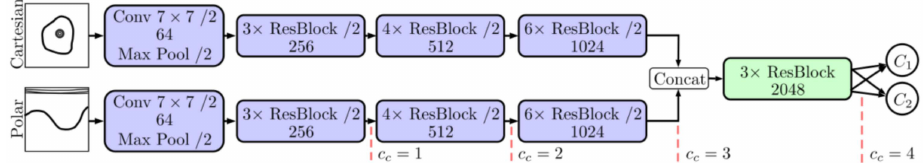
Figure 9. Layout of the dual-path ResNet model for automated extraction, making use of both the cartesian and polar image representations. Points Cc represent varying concatenation locations which were assessed for the two paths. © [2019] IEEE. Reprinted, with permission, from